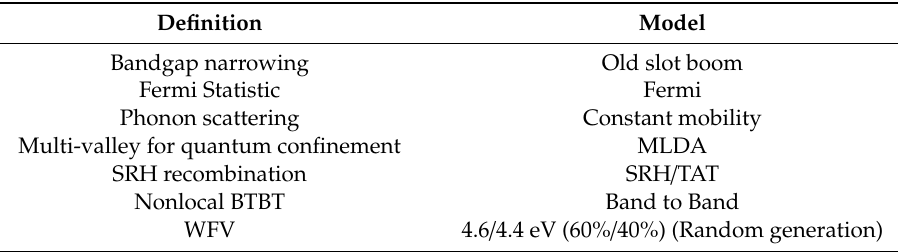
Table 2. Models in TCAD